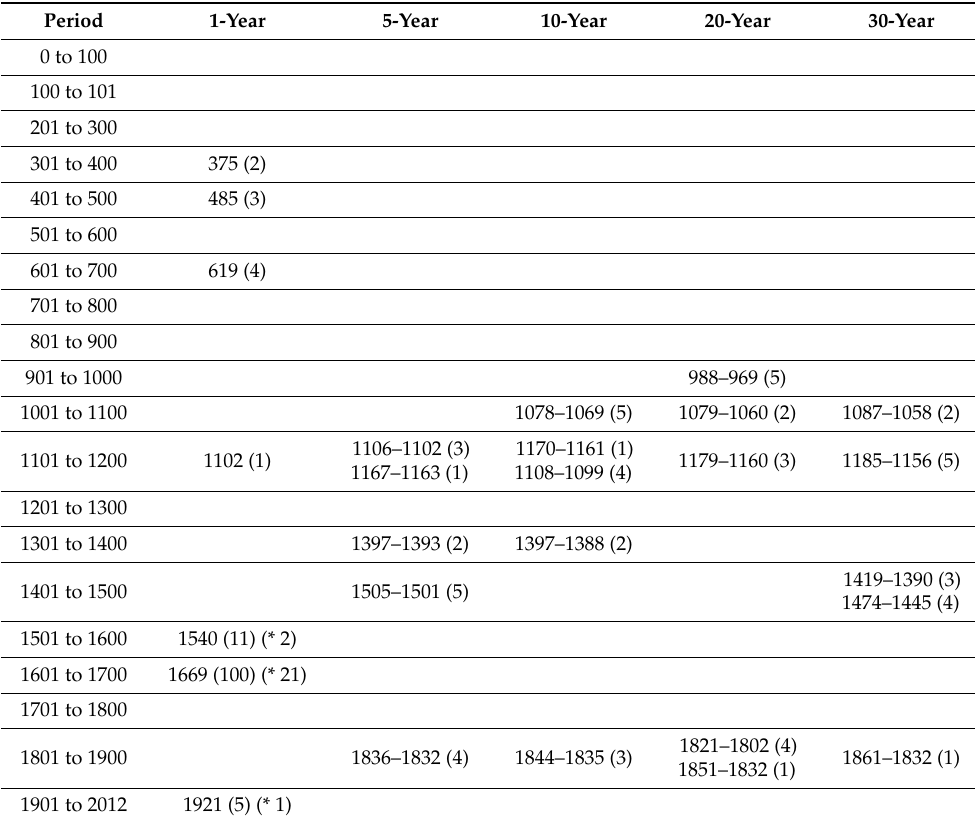
Table 2. Drought periods for the upper ARB regional reconstruction from 0 to 2012 AD. The number in the parenthesis represents the drought period ranking from 0 to 2012 AD while the number in the parenthesis with the “*” represents the drought period ranking from 1500 to 2012